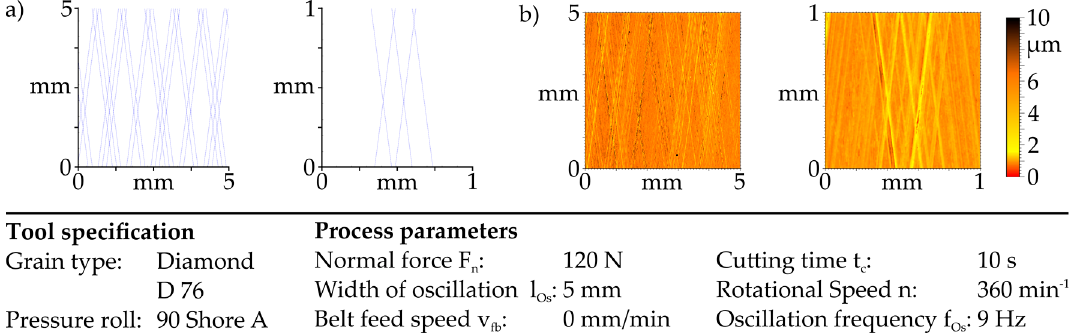
Figure 3. Verification of the simulation. ( a ) Simulated structure; ( b ) microfinished structure.